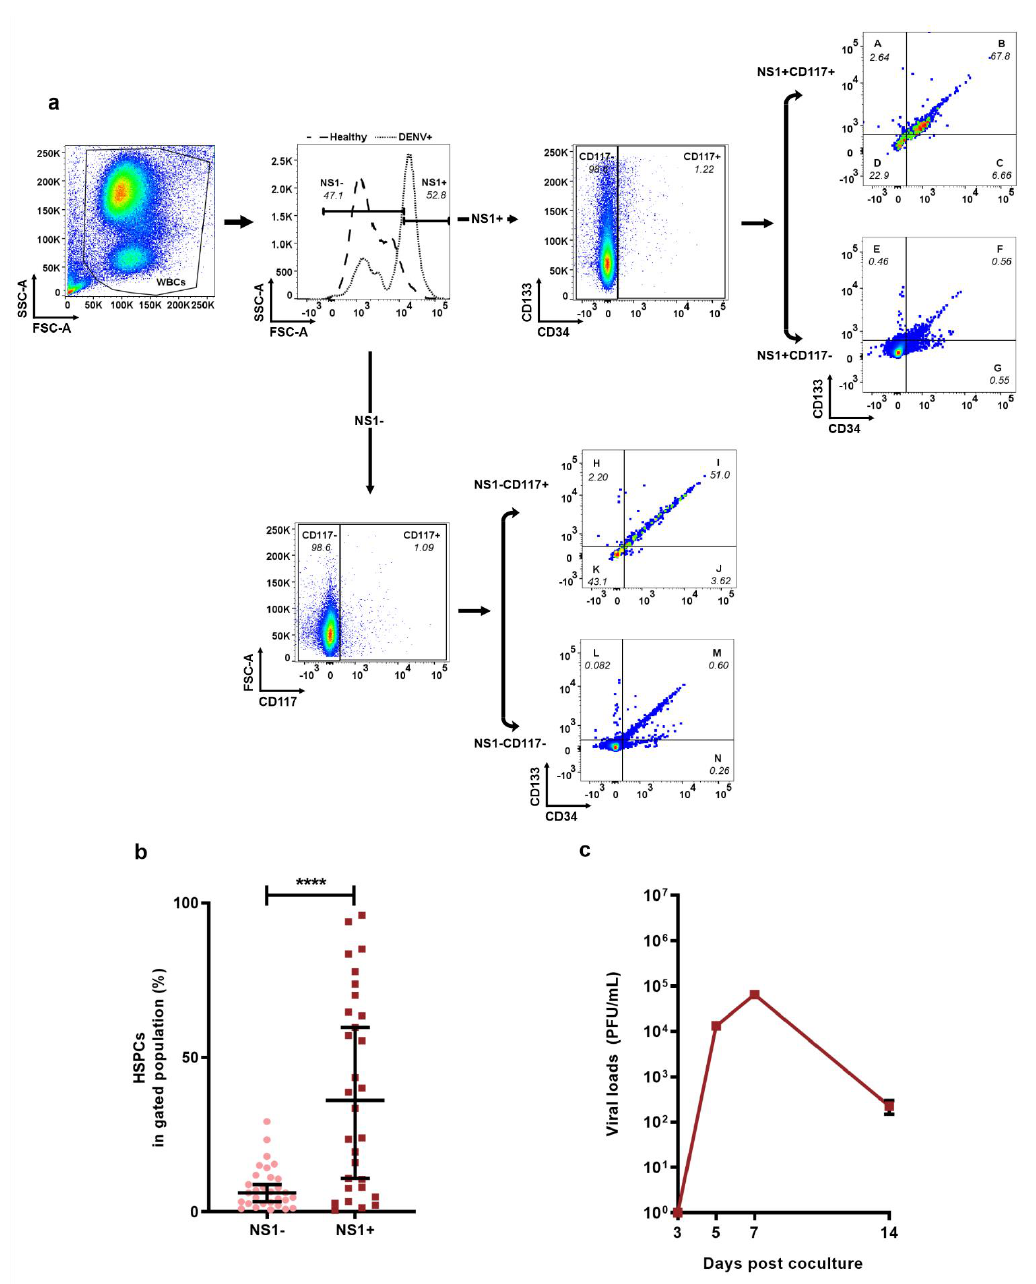
Figure 3. HSPCs were permissive to DENV infection. ( a ) Gating strategy of DENV − infected and − uninfected HSPCs. ( b ) Percentage of DENV − infected HSPCs (NS1+, n = 30, ■ ) and DENV − uninfected HSPCs (NS1 − , n = 30, ● ). ( c ) The kinetic titer of DENV recovered from HSPCs after coculture with Vero cells (n = 3). Data represented as median (IQR). p < 0.0001 ****.